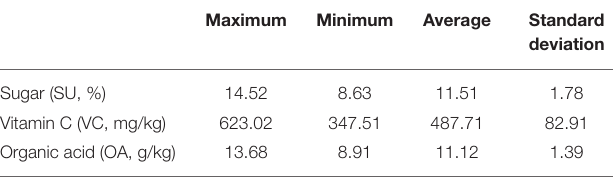
TABLE 1 | The descriptive statistics for the SU, VC, and OA of the 248 pomelo fruit samples. Maximum